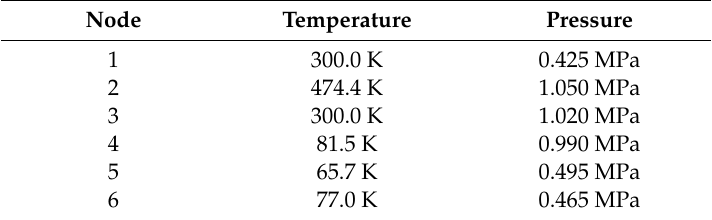
Table 2. Node values of the reverse Brayton cryogenic system.